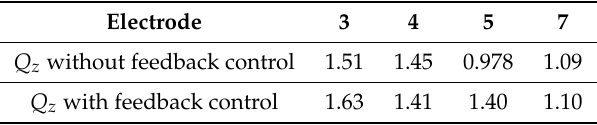
Figure 9. Oscillation amplitudes with and without feedback control at the resonance frequencies corresponding to electrodes ( a ) 3, ( b ) 4, ( c ) 5, and ( d ) 7. The feedback control amplified the oscillation amplitude at the resonance position for all electrodes except for electrode 4, and the frequency selectivity was improved, as quantitatively demonstrated by Q z values in Table 3. Although electrical stimuli were applied to electrodes 3, 4, and 5 to control these oscillations, unexpected behavior occurred at electrode 3, and electrode 4 did not show the maximum oscillation amplitude at its resonance frequency. Table 3. Evaluation index Q z for the frequency selectivity of the artificial cochlear sensory epithelium. The frequency selectivity was improved for electrodes 3, 5, and 7 by applying local electrical